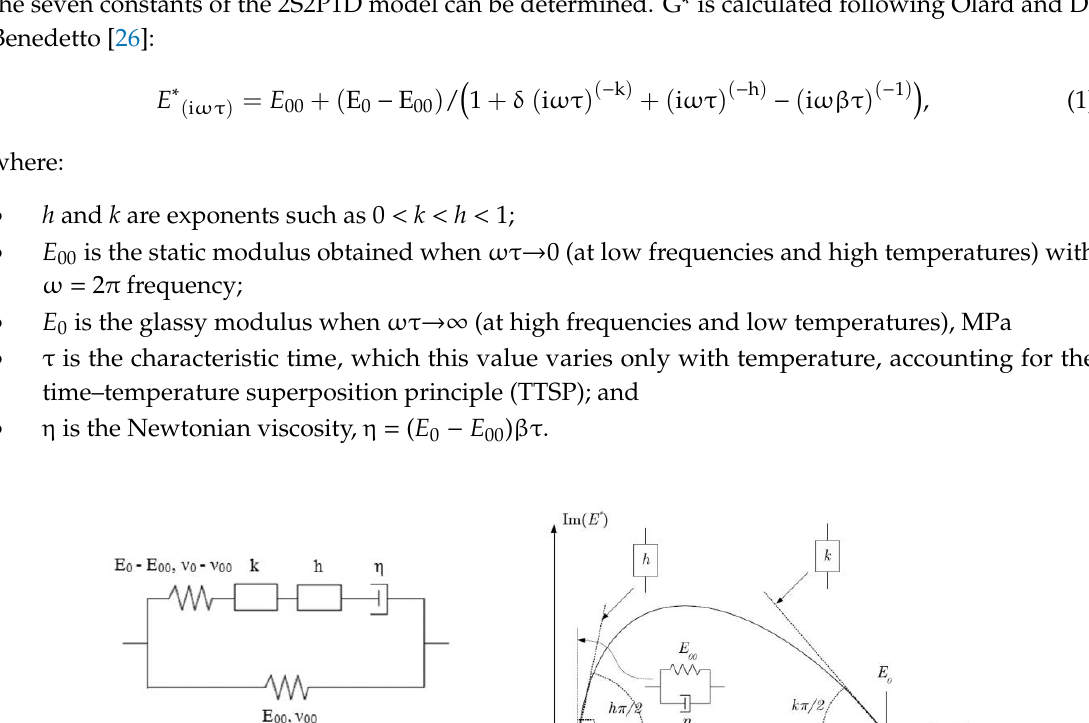
Table 1. Fourier transform infrared (FTIR) bands with bitumen aging [27].